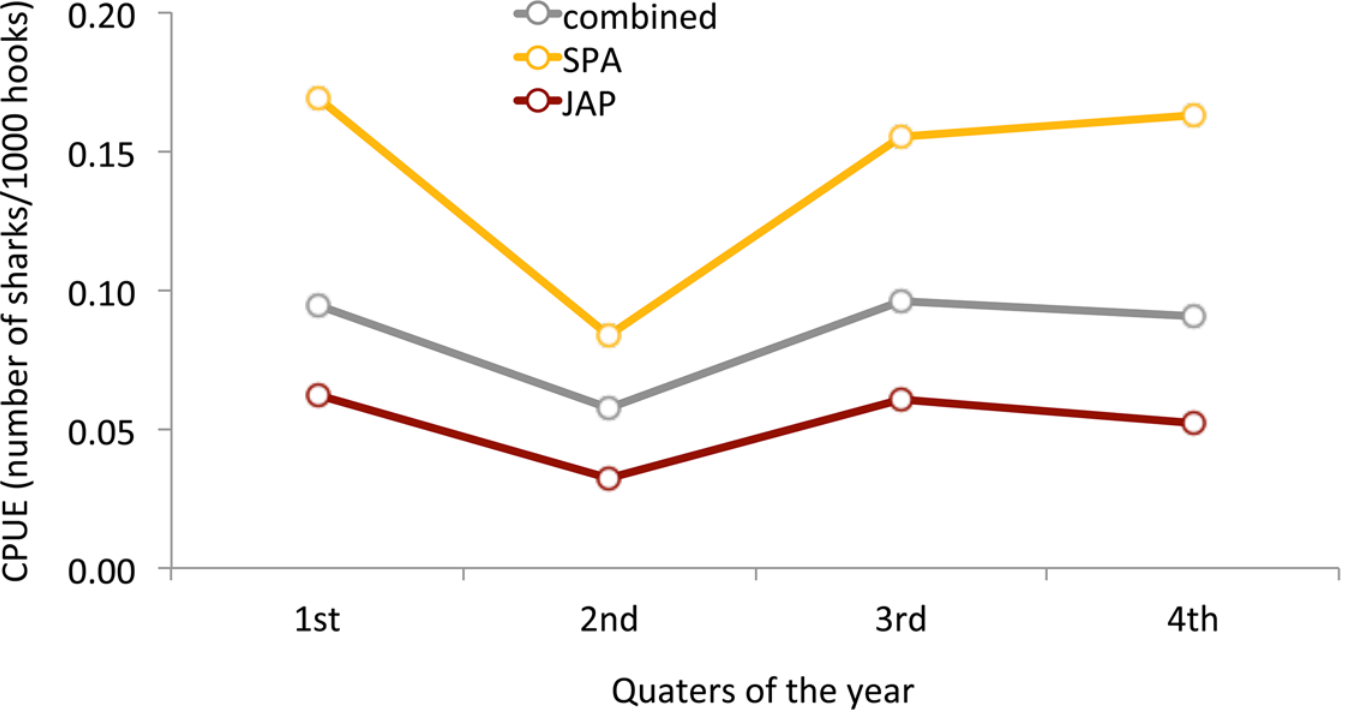
Fig 6. Mean CPUE values of oceanic whitetip sharks caught by foreign tuna longline vessels chartered by Brazil operating from 2004 to 2010.